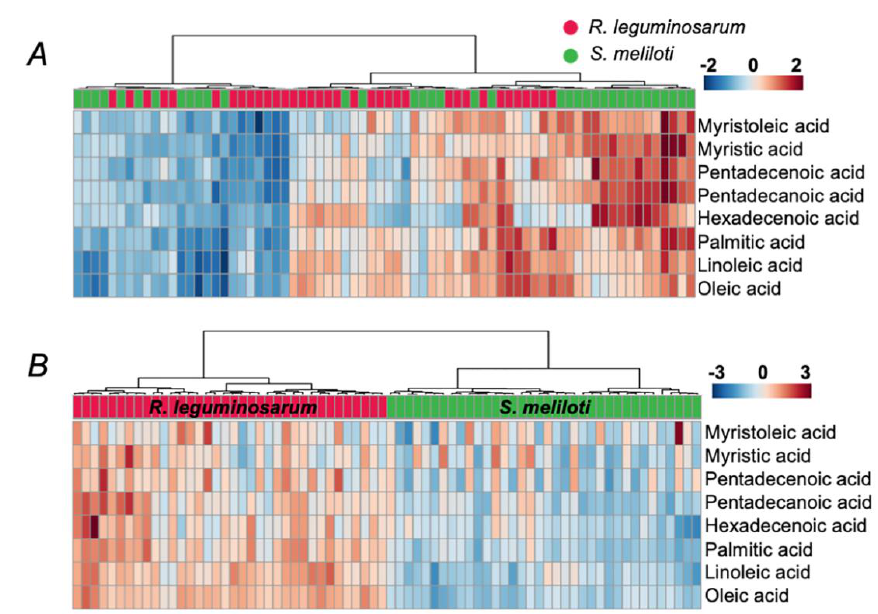
Figure 6. Heat maps of FFA patterns across all spectra (biological, spotting and acquisition replicates), acquired for R. leguminosarum and S. meliloti samples, obtained by the extraction from aqueous lysates ( A ) and n -hexane lysates ( B ). Data were processed in the Progenesis MALDI software with data normalization to the intensities (peak heights) of the signal at m / z 421.17 within a given mass range. The data matrix was further analyzed by the MetaboAnalyst 4.0 on-line software platform (https: // www.metaboanalyst.ca / ). Technical replicates (showed as individual columns) demonstrate a higher degree of similarity in comparison to the biological ones.